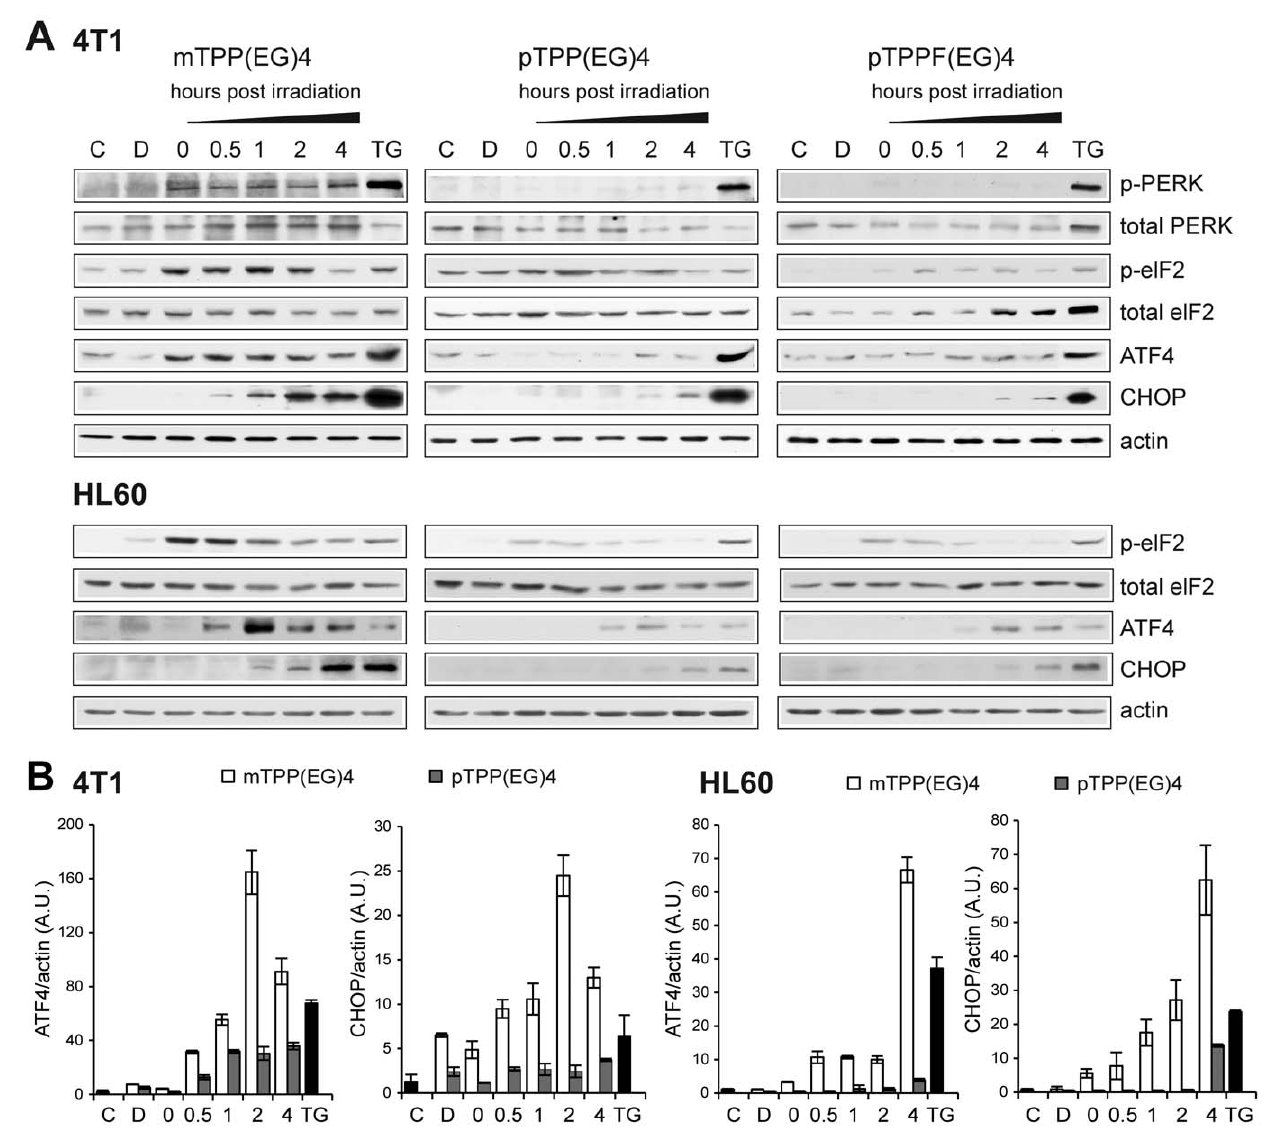
Figure 8. Kinetics of PERK pathway activation by EG-porphyrin-mediated PDT. ( A ) The induction of ER stress proteins (P-PERK, P-eIF2 a , ATF4, CHOP) detected by Western blot analysis. The activity of PERK and eIF2 a was determined by phospho-specific antibodies (p-) and then the membranes were reprobed with antibodies to total PERK and eIF2 a . Equal protein loading is demonstrated by actin reprobing. As a positive control were used cells treated with 1 m M thapsigargin (TG) for 6 h. ( B ) qRT-PCR analysis of total mRNA isolated from PDT-treated 4T1 and HL60 cells. cDNA was prepared from total mRNA and quantitative real-time RT-PCR for ATF4, CHOP and b -actin mRNA was performed. mRNA fold induction values were calculated from ATF4/actin and CHOP/actin ratios as described in Materials and Methods. Experiments were performed in triplicate.